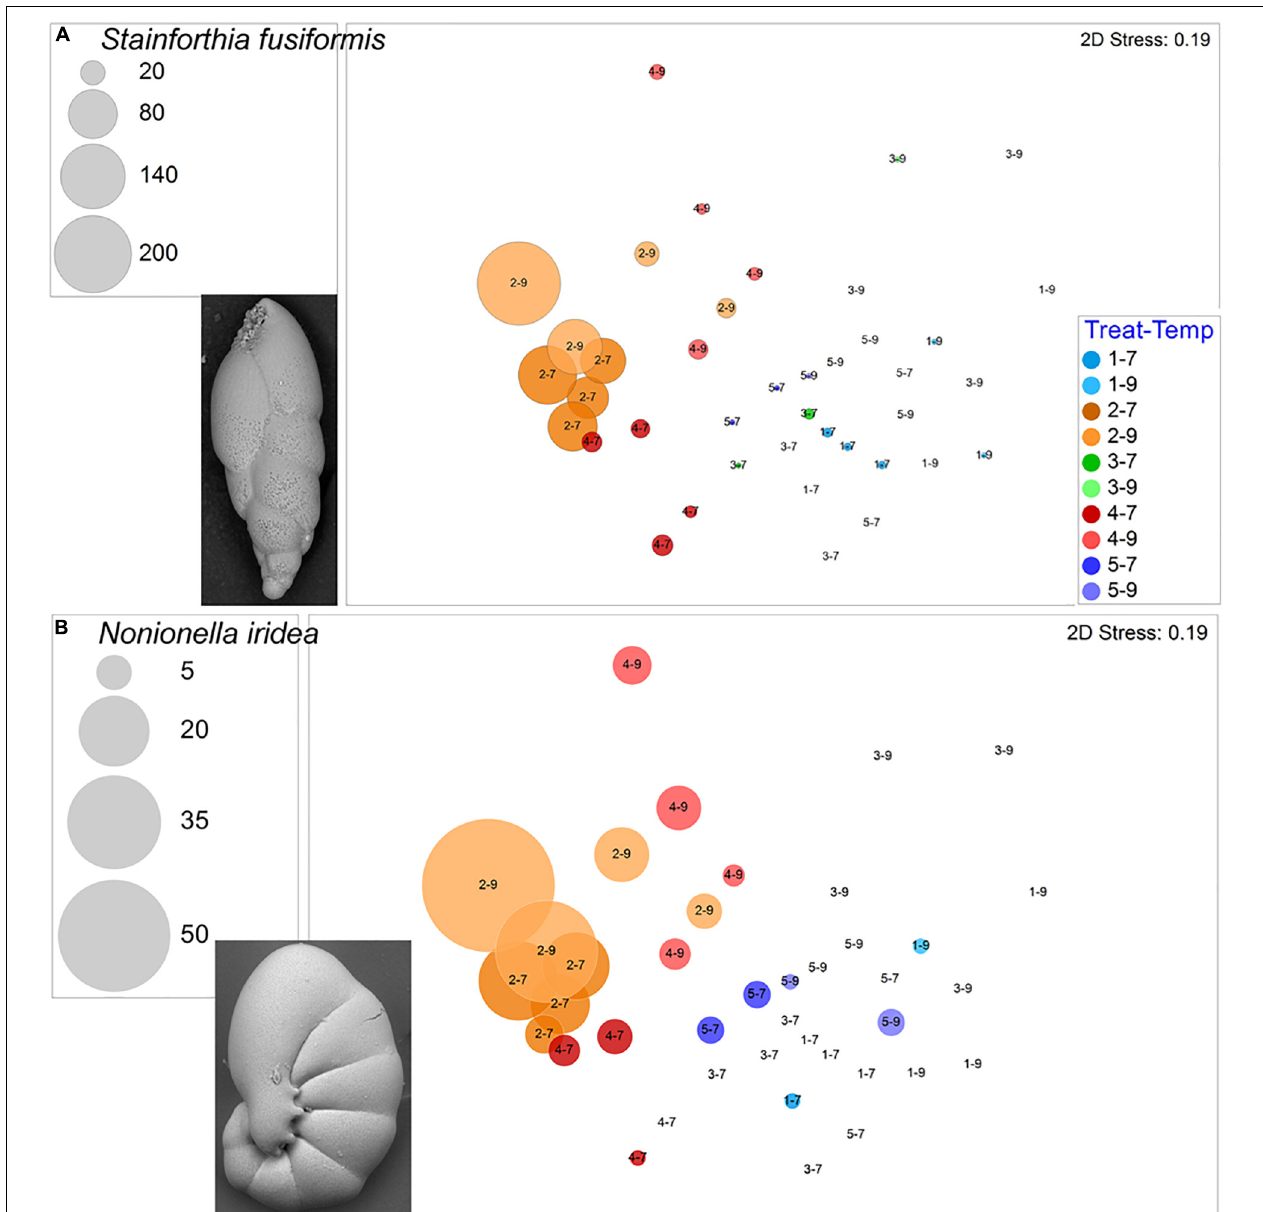
FIGURE 8 | Bubble plots projecting abundances in containers (7 ◦ C Total/9 ◦ C Live) by morphospecies on 2-D nMDS plots. Bubbles are color coded to treatment; lighter shade represents warmer assemblages. Circle diameter is keyed to abundance. Insets are SEM micrographs of the morphospecies. (A) Stainforthia fusiformis ; (B) Nonionella iridea . Treatment 1 (blue) is Present Day; Treatment 2 (orange) is Hypoxia; Treatment 3 (green) is OA; Treatment 4 (red) is OA + Hypoxia; Treatment 5 (purple) is